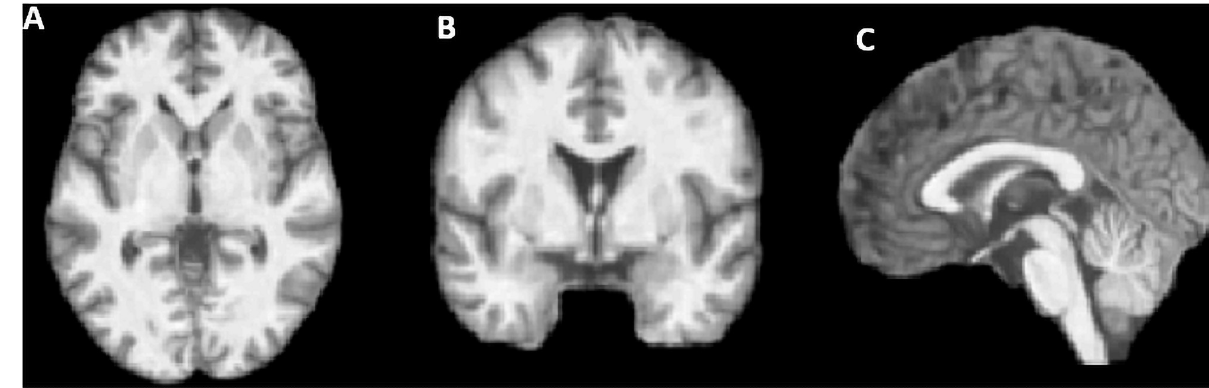
Fig 2. T 1 -weighted skull-stripped images of a healthy volunteer in the axial (A), coronal (B), and sagittal (C) planes of a volunteer.